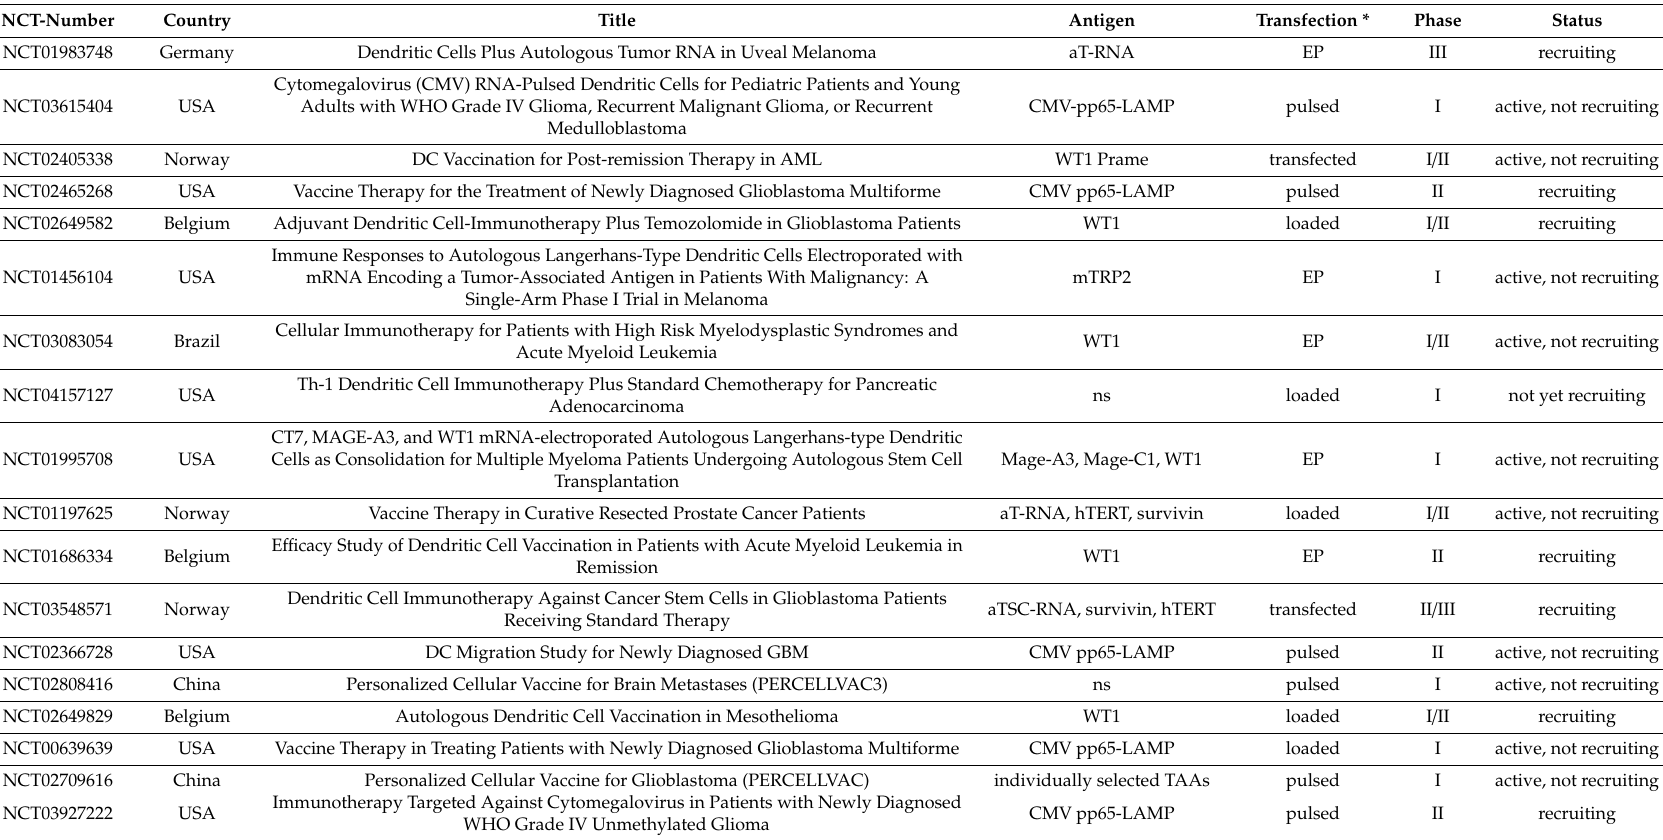
Table 4. Active clinical trials with RNA-transfected DCs (from clinicaltrials.gov; status December